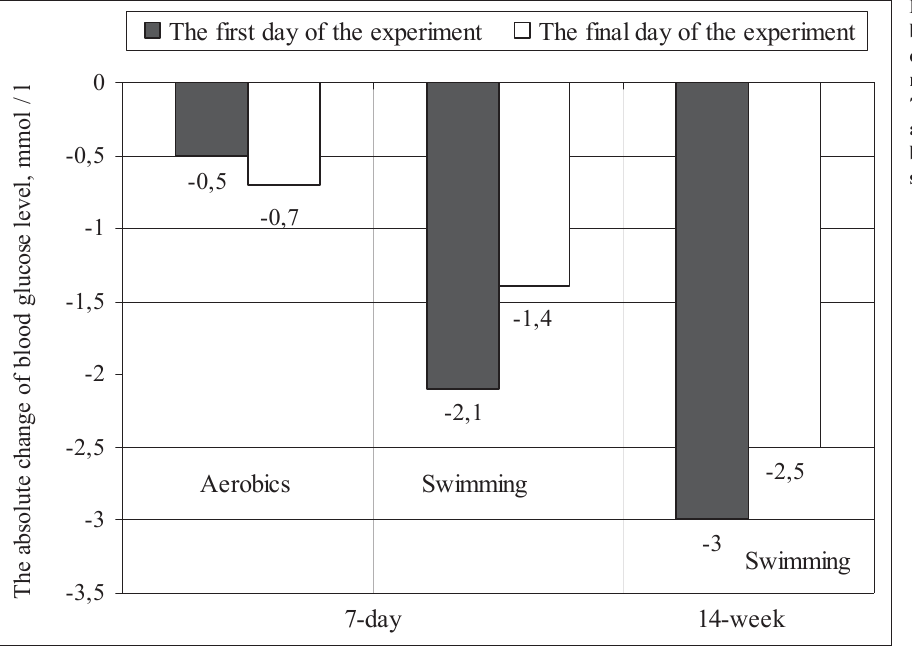
Fig. The absolute change of blood glucose level (mmol / l) of girls with type 1 diabetes mellitus before and after the 7-day physical program — aerobics and swimming, and before and after the 14-week swimming